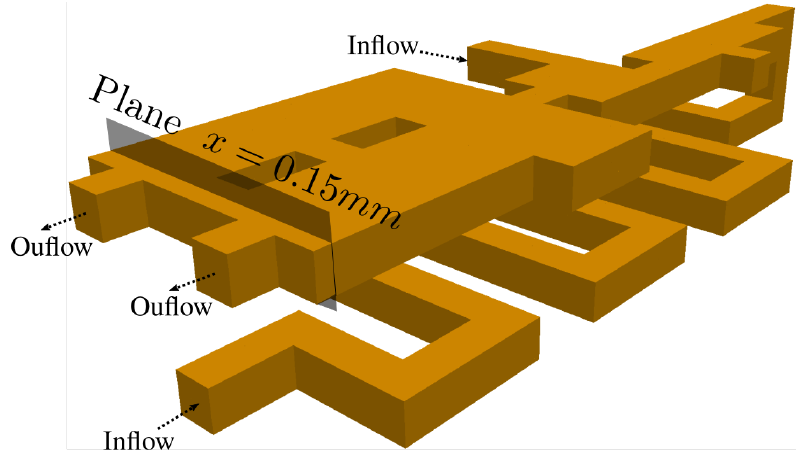
Figure 9. Geometry for the complex 3D array of channels.